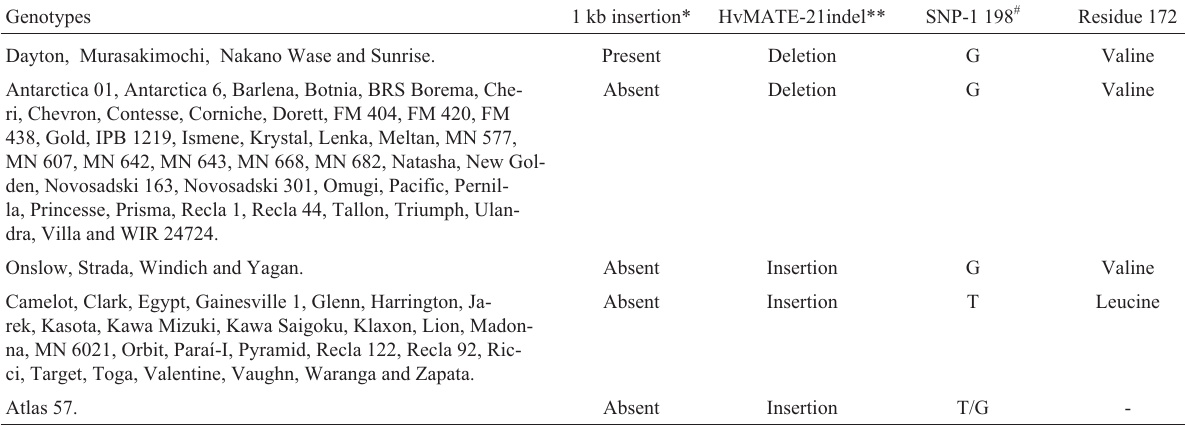
Table 1 - HvAACT1 haplotypes identified in 76 cultivated barley genotypes based on two markers linked in the HvAACT1 gene and SNP-1,198.